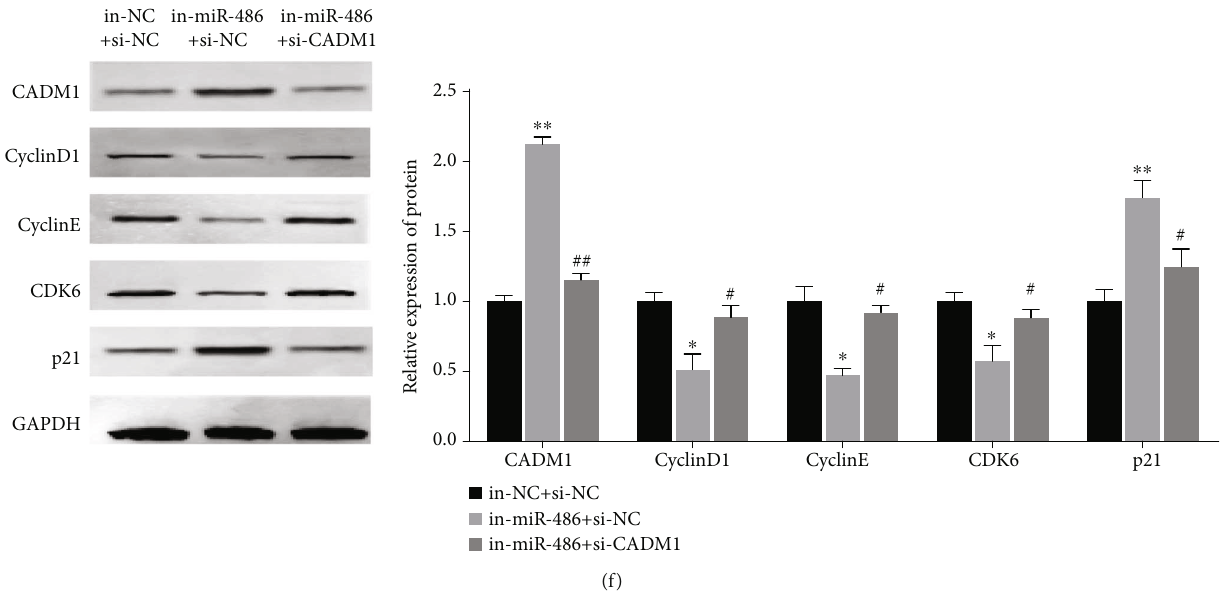
Figure 4: miR-486 downregulates CADM1 to be involved in the biological function of OC cells. (a) CCK-8 assay to detect the cell viability of SKOV3 after transfection with in-NC+si-NC, in-miR-486+si-NC, and in-miR-486+si-CADM1; (b) colony formation assay to detect the cell colony formation ability of SKOV3 after transfection with in-NC+si-NC, in-miR-486+si-NC, and in-miR-486+si-CADM1; (c) Transwell assay to detect the invasion ability of SKOV3 after transfection with in-NC + si-NC, in-miR-486+si-NC, and in-miR-486+si-CADM1; (d, e) FCM to detect the apoptosis rate and cell cycle of SKOV3 after transfection with in-NC+si-NC, in-miR-486+si-NC, and in-miR-486+si- CADM1; (f) Western blot to detect the expression levels of cell cycle-related proteins p21, CyclinD1, CyclinE, and CDK6. ∗ P < 0 : 05 and ∗∗ P < 0 : 01 vs. the in-NC+si-NC group; # P < 0 : 05 and ## P < 0 : 01 vs. the in-miR-486+si-NC